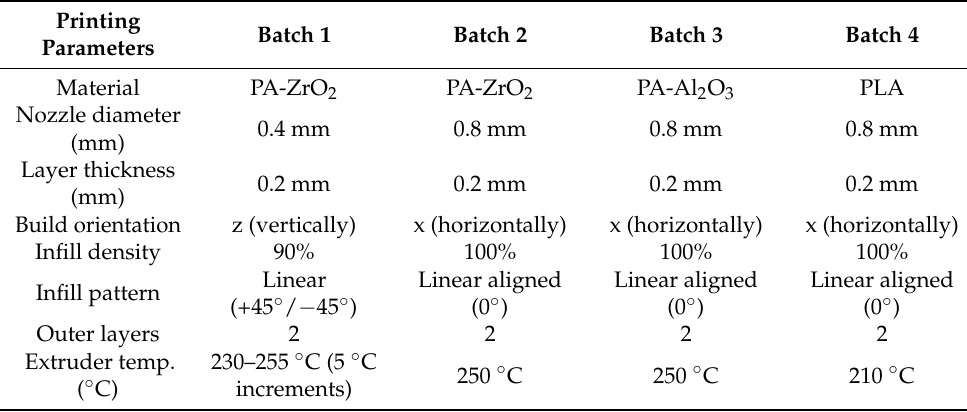
Table 1. Processing parameters of the tensile test